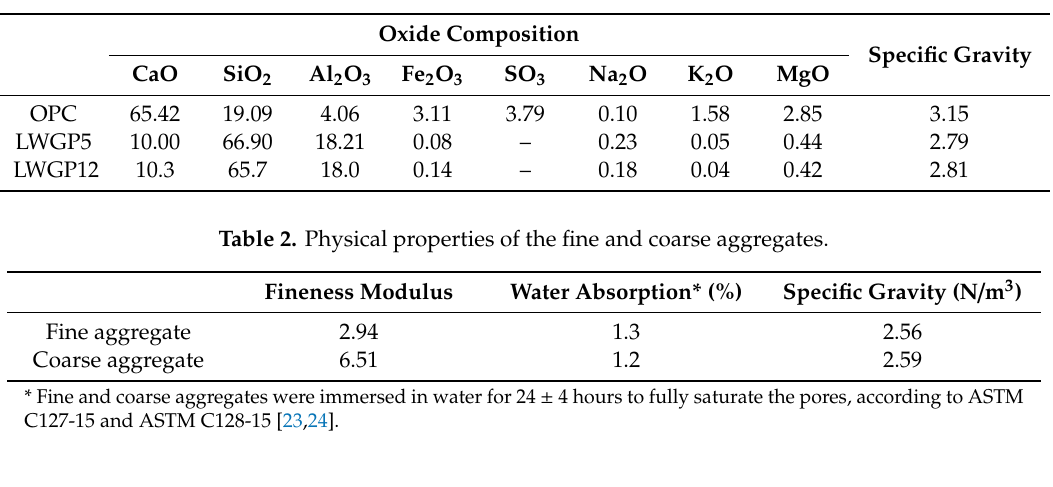
Table 1. Chemical and physical properties of binders.